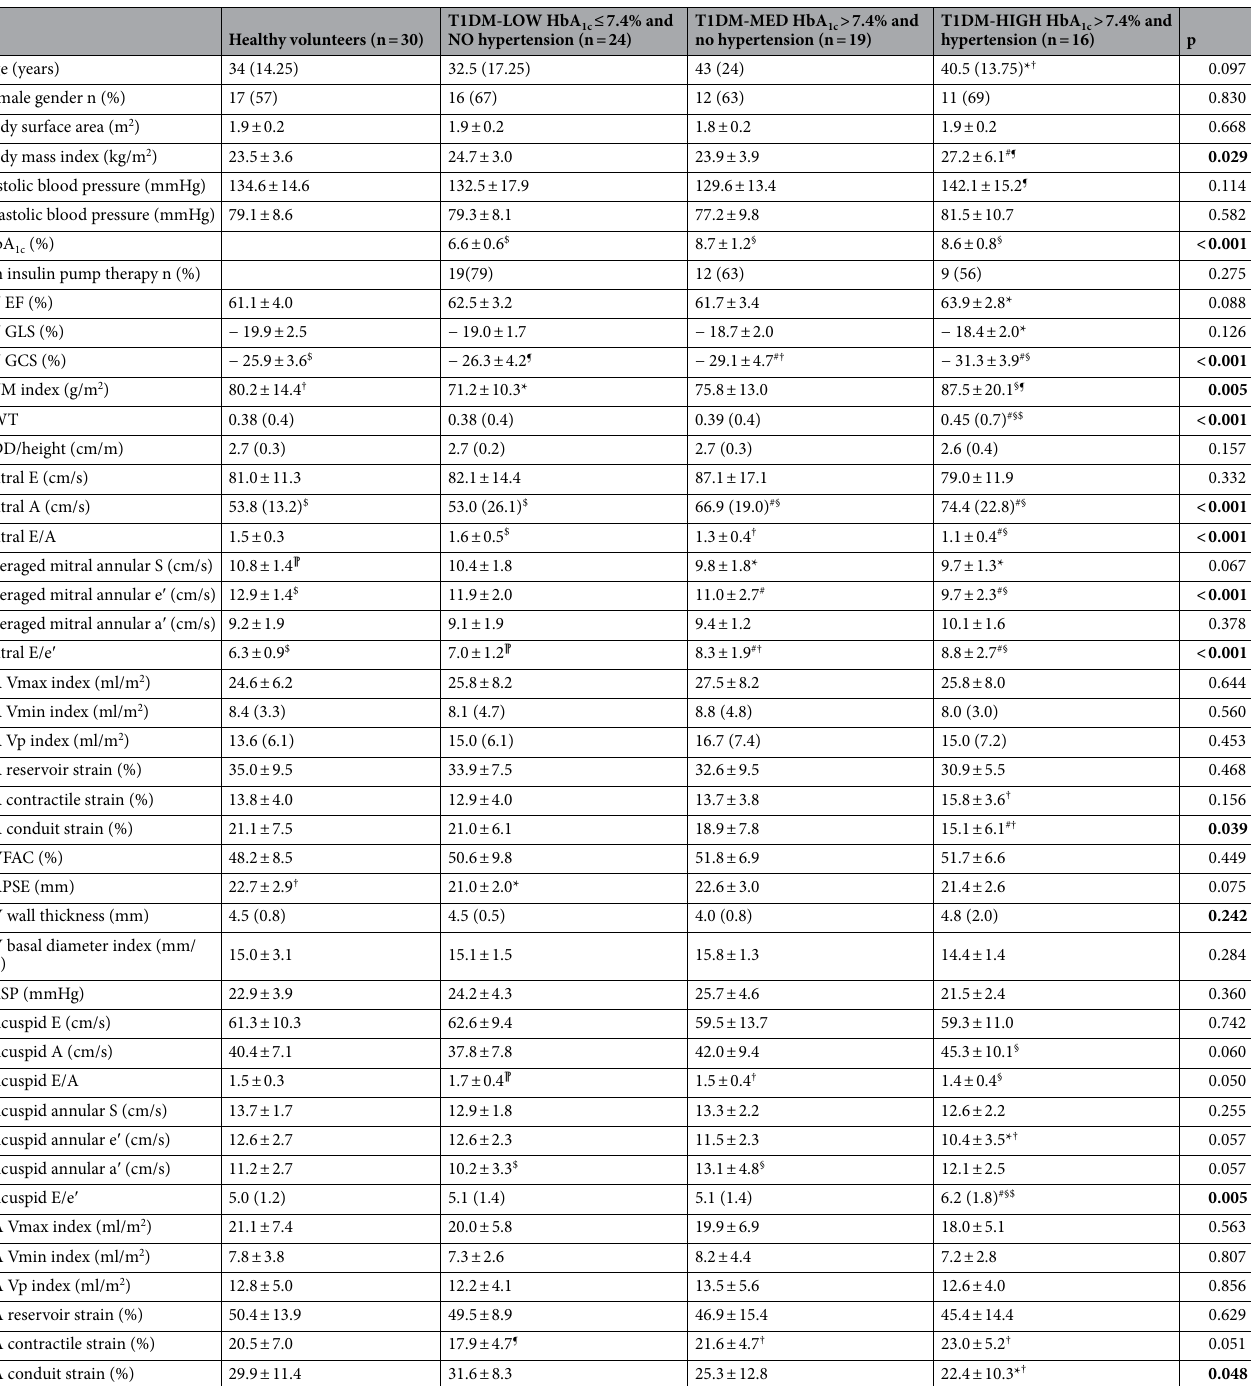
Table 4. Comparison of echocardiographic variables among healthy subjects and T1DM subgroups. Statistically significant p-values (p < 0.05) are formatted in bold. *p < 0.05 versus NORM; # p < 0.01 versus versus